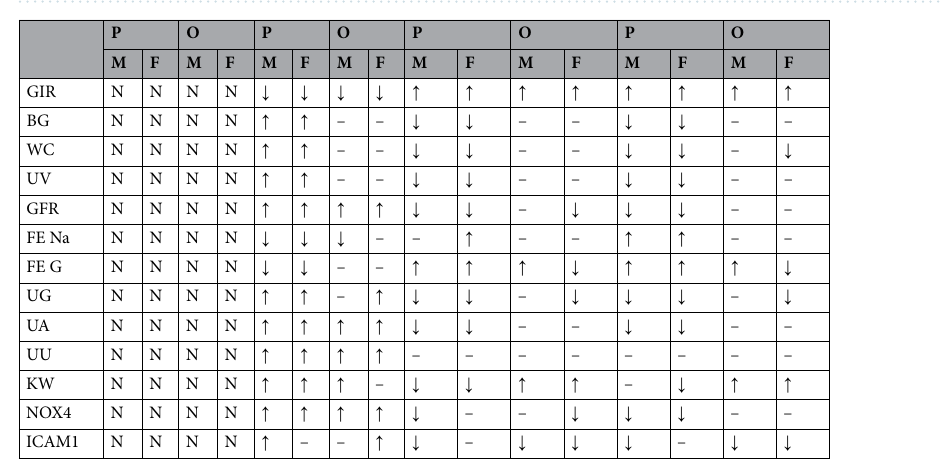
Figure 1. Experimental design, 48 male (M) and female (F) rats at 4 weeks old, weighing 80–90 g are used in the study.